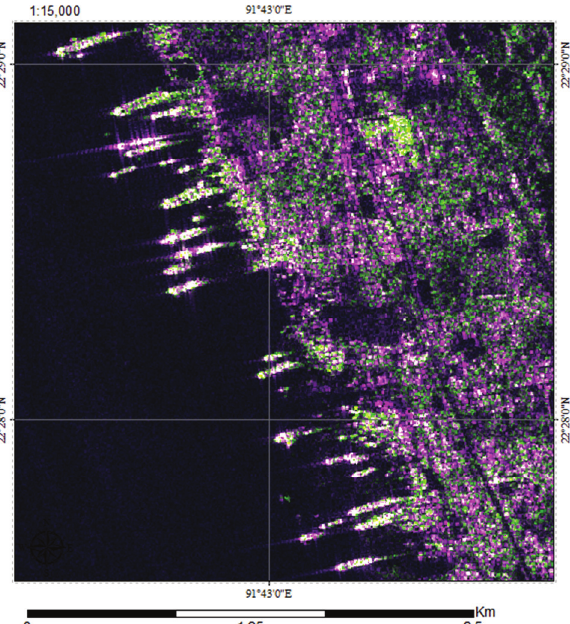
Figure 8. ALOS-2 Strip map mode over the ship breaking yards of Chittagong on February 20, 2015 around acquisition time (23:54, Local Time) at 1:15,000 scale. PALSAR-2 color-composite image (Red: HH, Green: HV, Blue: HH/HV) ©JAXA Distributed by